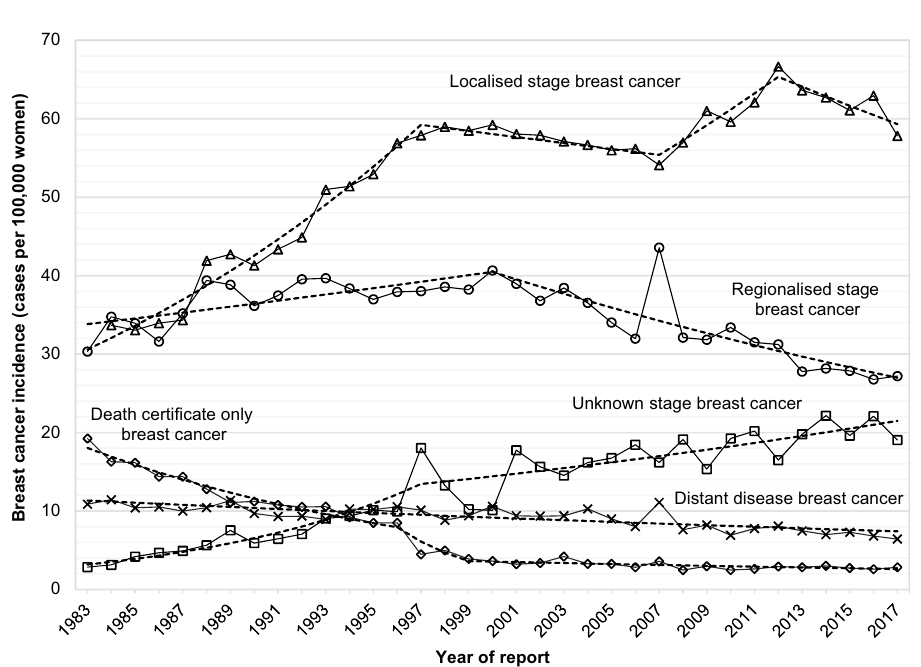
Figure 4. Stage-specific incidence of breast cancer in women in Austria according to year of diagnosis, 1983–2017 (age-standardised, European standard population 2013). Dashed lines indicate joinpoint regression